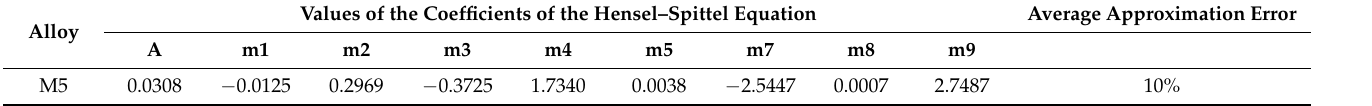
Figure 9. Hydrostatic pressure distribution in rhombic flat anvils.